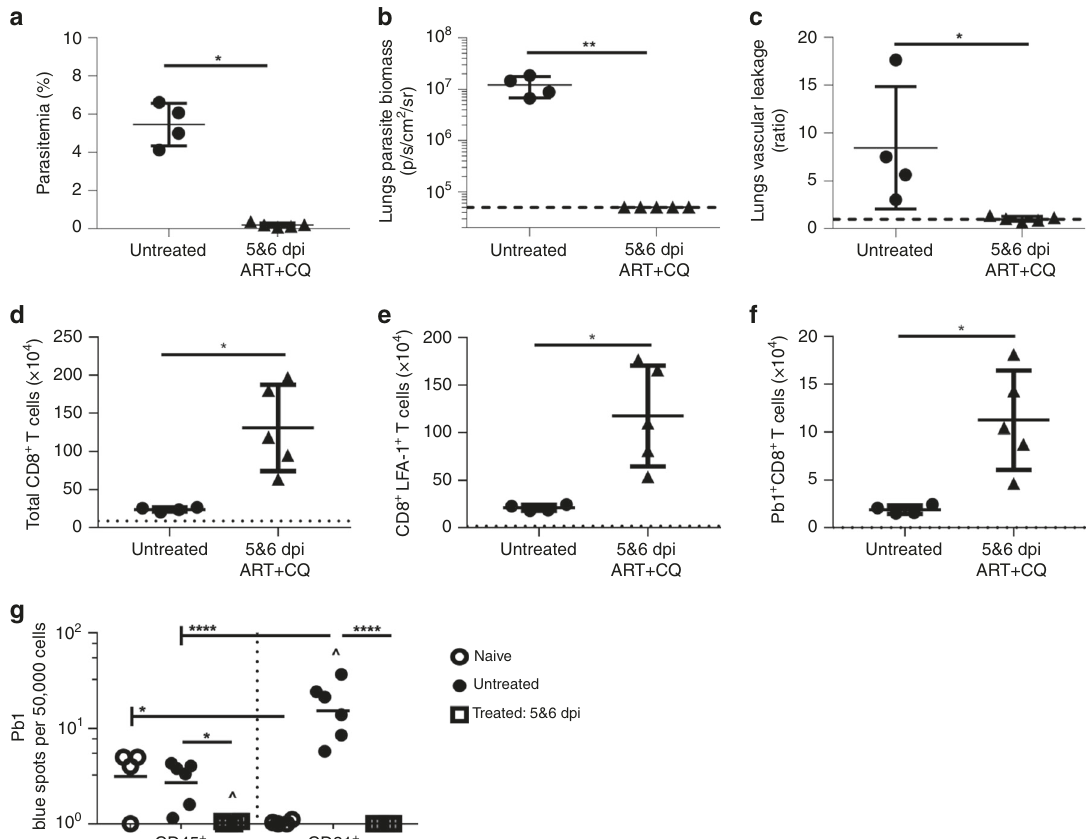
Fig. 9 Anti-malarial treatment protects infected mice from pulmonary leakage and abrogates cross-presentation of malaria antigen by lungs endothelial cells. Comparison between PbA luc -infected C57BL/6 mice (untreated) ( n = 4) and infected mice treated with artesunate and chloroquine (ART + CQ) at 5 and 6 dpi (5&6) ( n = 5). All analyses were performed at 7 dpi. a Peripheral parasitemia. b Ex vivo quanti fi cation of parasite biomass in the lungs based on luciferase activity of PbA luc after perfusion. c Ratio of lung vascular leakage in vivo at 7 dpi measured by Tracer-653 dye. Total number of d CD8 + T cells, e CD8 + LFA-1 + T and f Pb1-speci fi c CD8 + T cells accumulated in the lungs at 7 dpi. The data were pooled from two independent experiments. g Lung microvessels were isolated at 7 dpi from the naïve C57BL/6 ( n = 4), untreated PbA luc -infected C57BL/6 mice ( n = 6) and infected mice treated with ART + CQ at 5 and 6 dpi ( n = 6) and sorted into two populations: CD45 + 31 − leukocytes and CD45 − CD31 + endothelial cells. Each sorted population was tested for Pb1 cross-presentation by incubating with LR-BSL8.4a cells and staining with X-gal. The spot count was normalized per 50,000 cells and represented on a log scale. For ex vivo quanti fi cation of parasite biomass in the lungs in ( b ), the data were expressed on a log scale, with naïve C57BL/6 mice represented by a black dashed line. The black dashed line at y = 1 in ( c ) represents the ratio of tracer reading from naïve C57BL/6 mice ( n = 3). The black dotted line in ( d – f ) represents the value of each respective cell population from naïve C57BL/6 mice for quanti fi cation of immune-cell populations in the lungs. The data represent the mean ± SD; * p < 0.05, ** p < 0.001, by Mann Whitney test ( a – f ); * p < 0.05, **** p < 0.0001, ^ statistically signi fi cant compared to naive ( p < 0.001, p < 0.0001), by ANOVA with Bonferroni ’ s post-test (